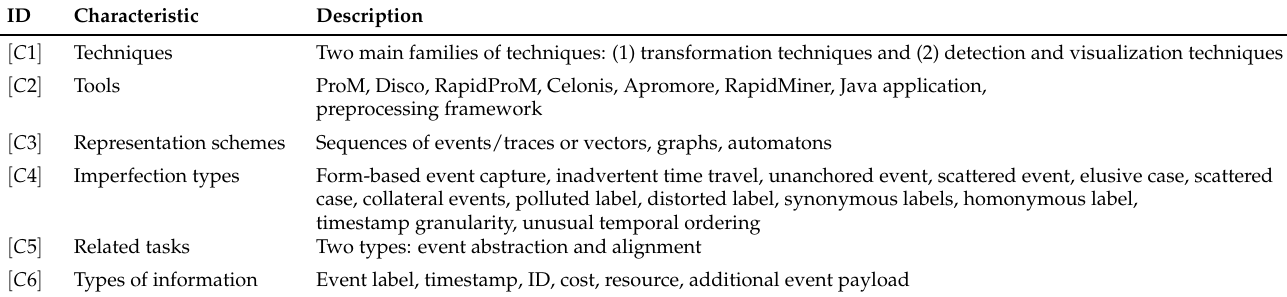
Table 2. Main characteristics in the reviewed